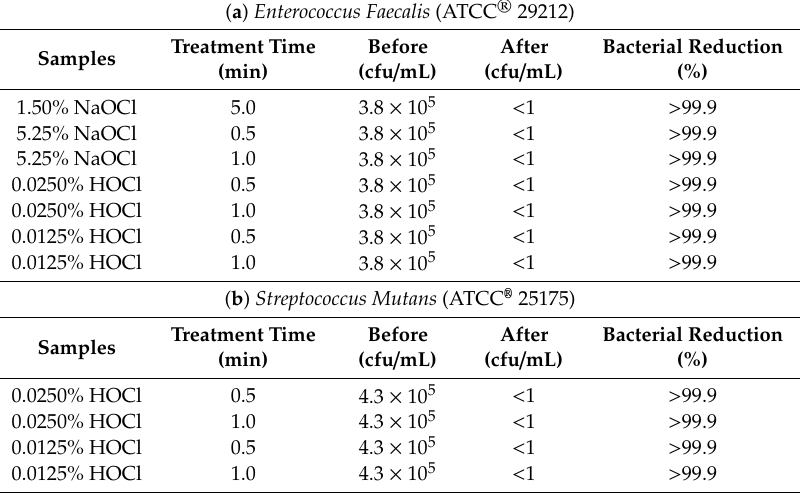
Table 1. Bacterial counts and reduction of ( a ) E. faecalis and ( b ) Streptococcus mutans before and after treatment.